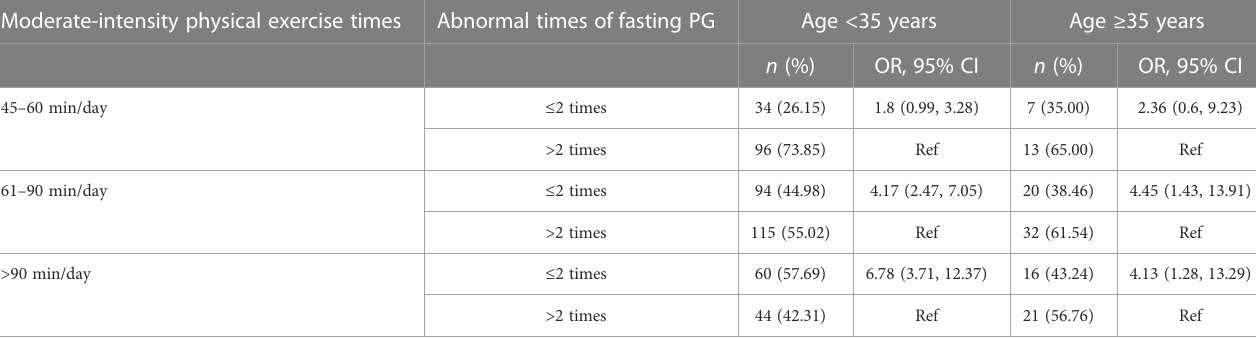
TABLE 2 The association between daily physical exercise duration and the number of abnormal FPG occurrences in women with GDM by age groups ( n = 878). Moderate-intensity physical exercise